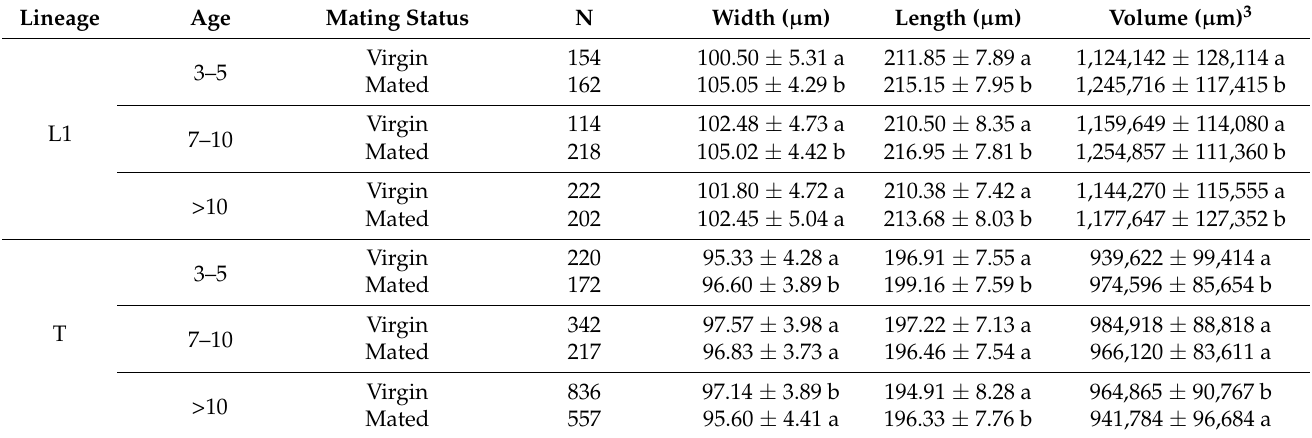
Table 5. Size of eggs produced by virgin and mated mothers of the L1 and T lineages in different age